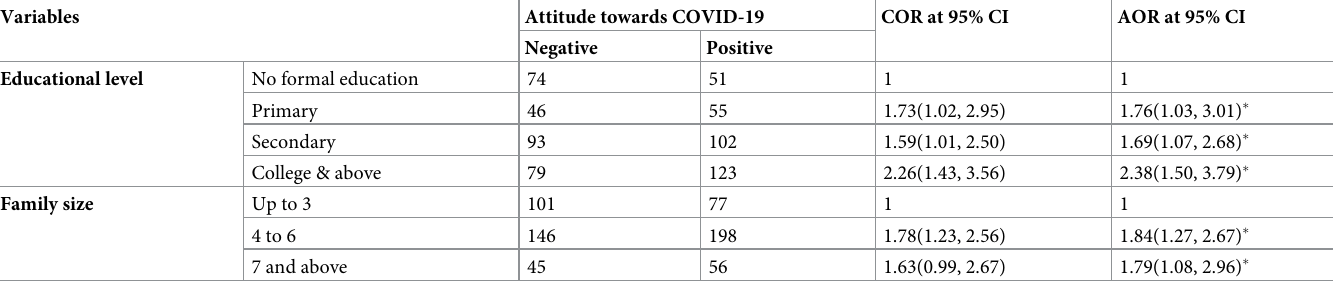
Table 5. Factors associated with attitude of communities towards COVID-19 in Gondar city, northwest Ethiopia, 2020.